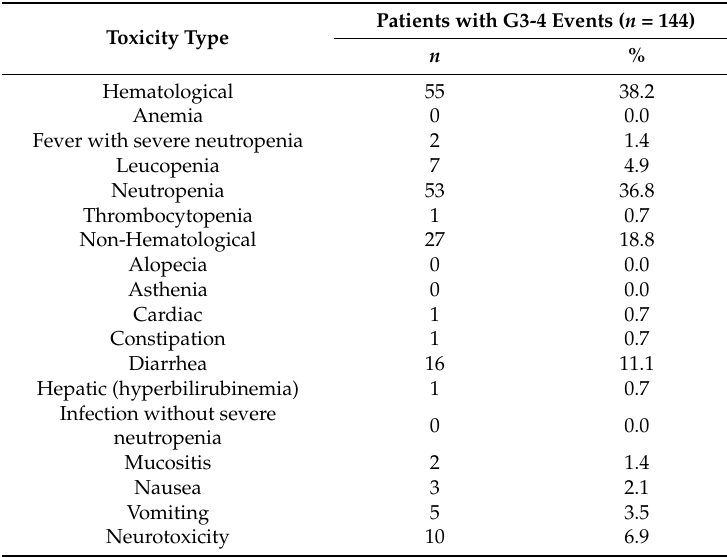
Table 2. Common cumulative toxicities reported in patients after folinic acid/5-fluorouracil/oxaliplatin (FOLFOX4)